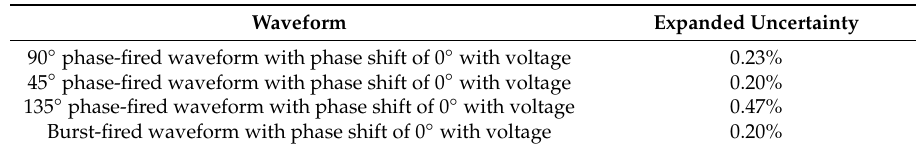
Table 2. Summary of uncertainties for distorted signals.